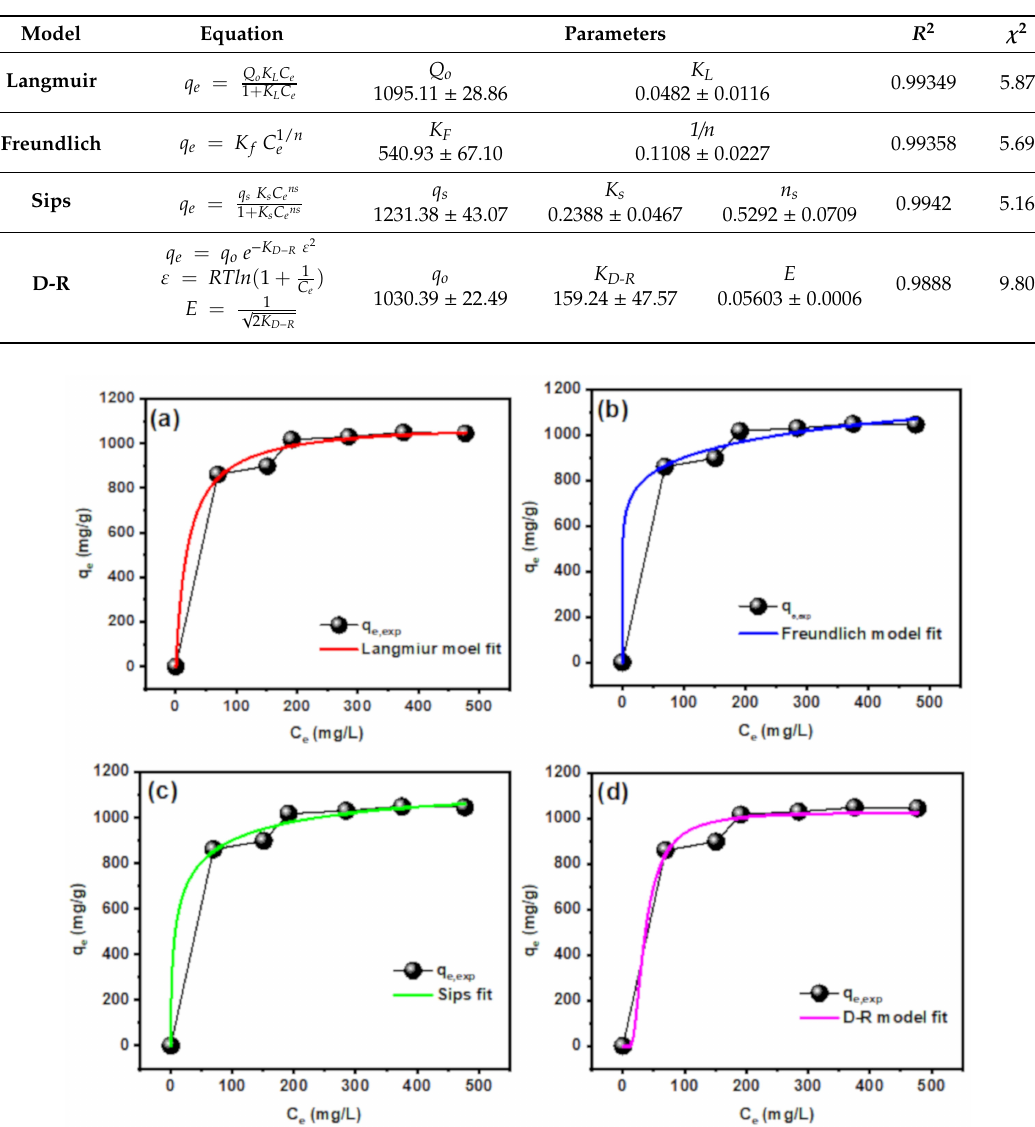
Figure 9. Adsorption isotherms of MB dye onto CT- g -PAA / O-ECNFs fitted by ( a ) Langmuir, ( b ) Freundlich, ( c ) Sips, and ( d ) Dubbinin-Radushkevich (D-R) non-linear